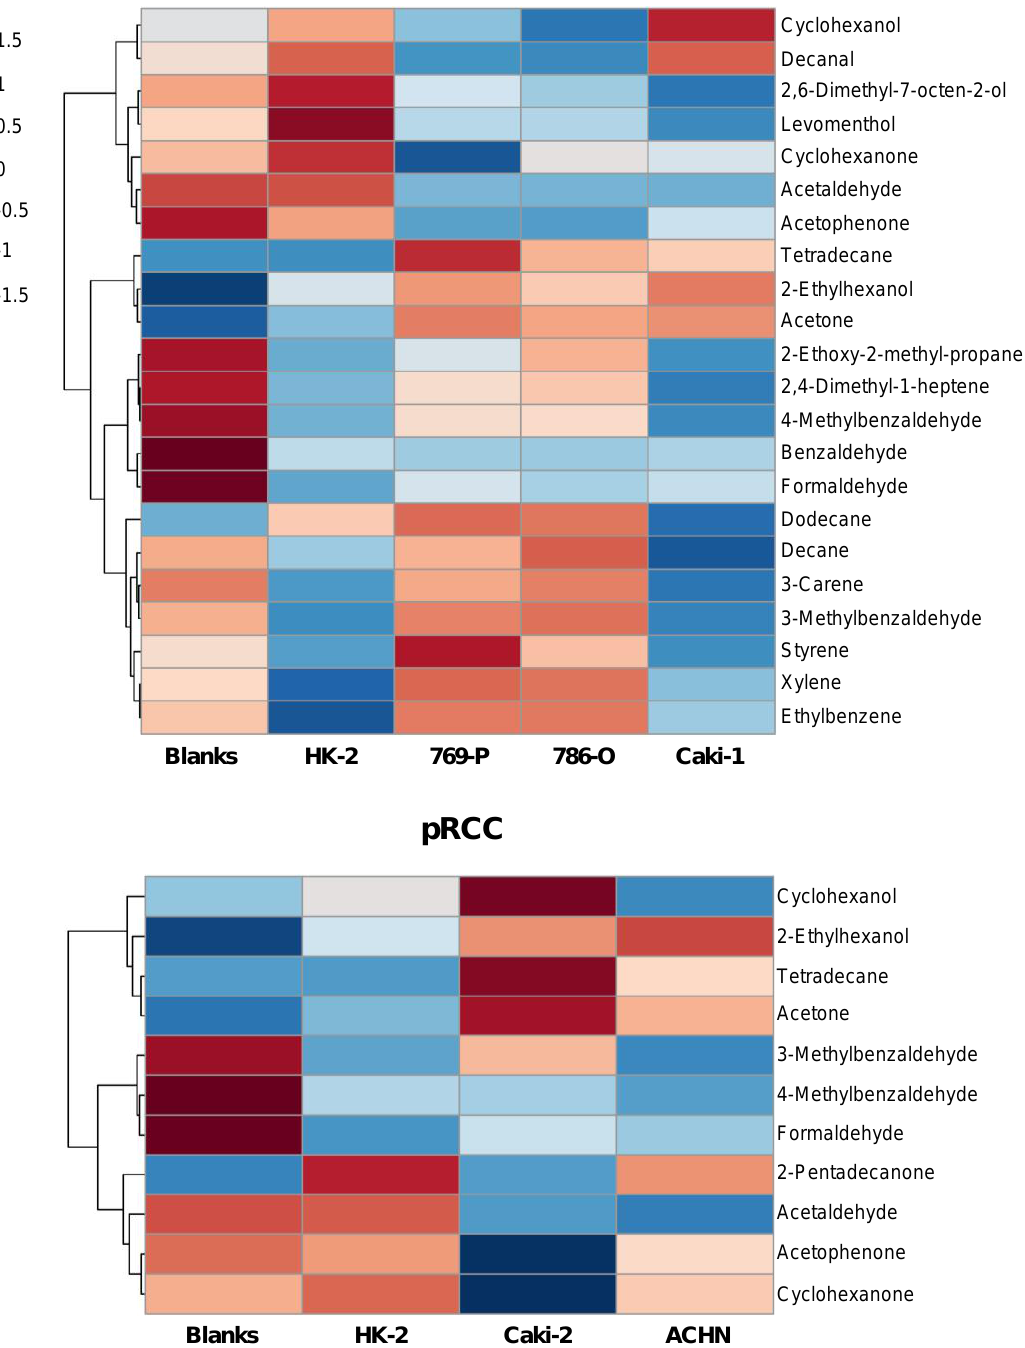
Figure 3. Heatmaps illustrating the mean levels (normalized peak areas) of metabolites changing in ccRCC and pRCC cell lines when compared with the non-tumor cell line (HK-2). The levels of those compounds in blanks (culture medium without cells) are also represented to aid in the interpretation of the results in terms of excretion and consumption. Rows correspond to the mean normalized peak area of each metabolite, while the columns represent each sample